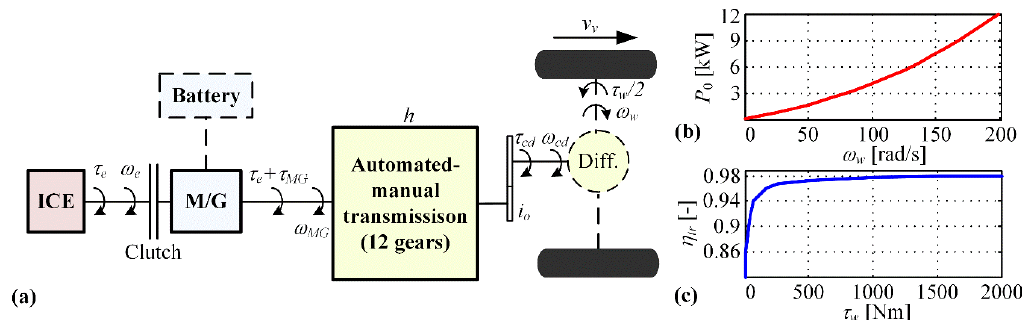
Figure 1. Parallel configuration of plug-in hybrid electric vehicles (PHEV) powertrain ( a ), transmission idle-mode power loss map ( b ), and mechanical efficiency map ( c ).